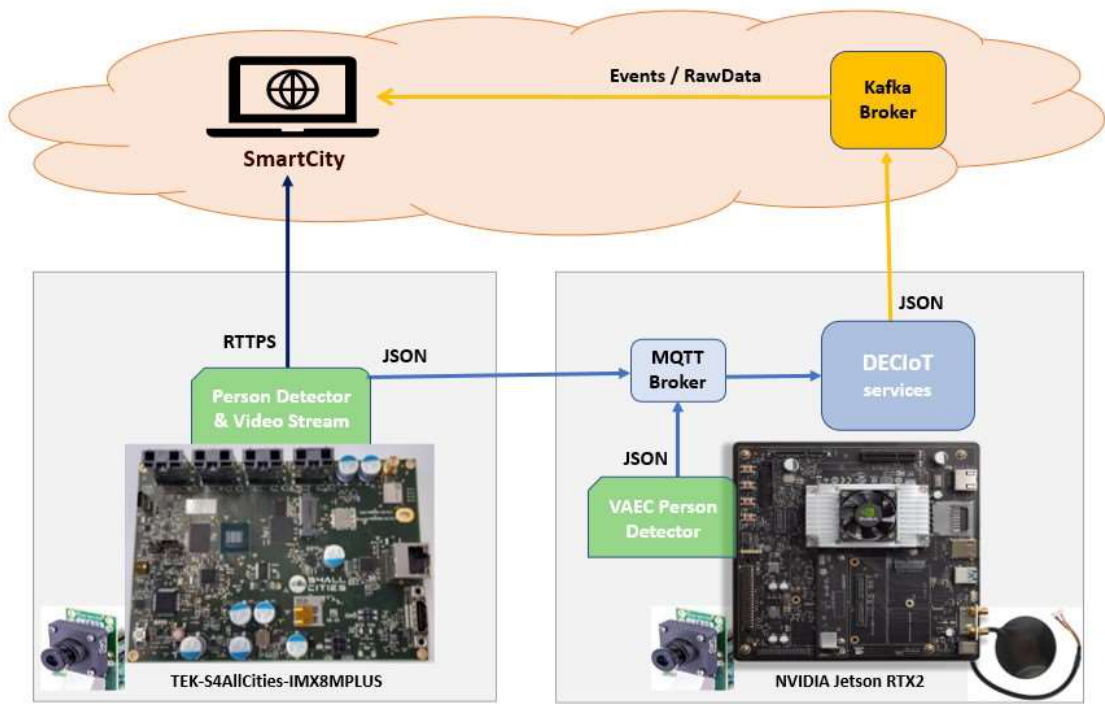
Figure 2. S4AllCities schema with ICCS (VAEC via NVIDIA Jetson RTX2) and Tekniker (I.MX8M Plus) edge platforms transmitting video streaming and the number of people detected.